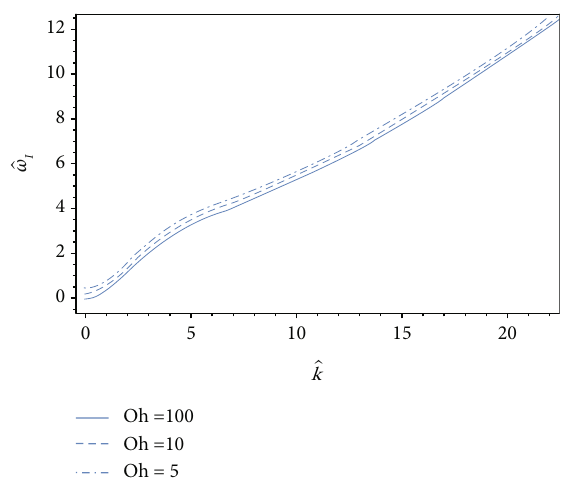
Figure 2: Growth rate curves for various values of Ohnesorge number at b ρ = 0 : 002 , b μ ′ = 0 : 6 , b μ = 0 : 4 , L = 0 : 3 , = 3 , Ce = 6 , and ̂ H = 20 : Ce 2 1